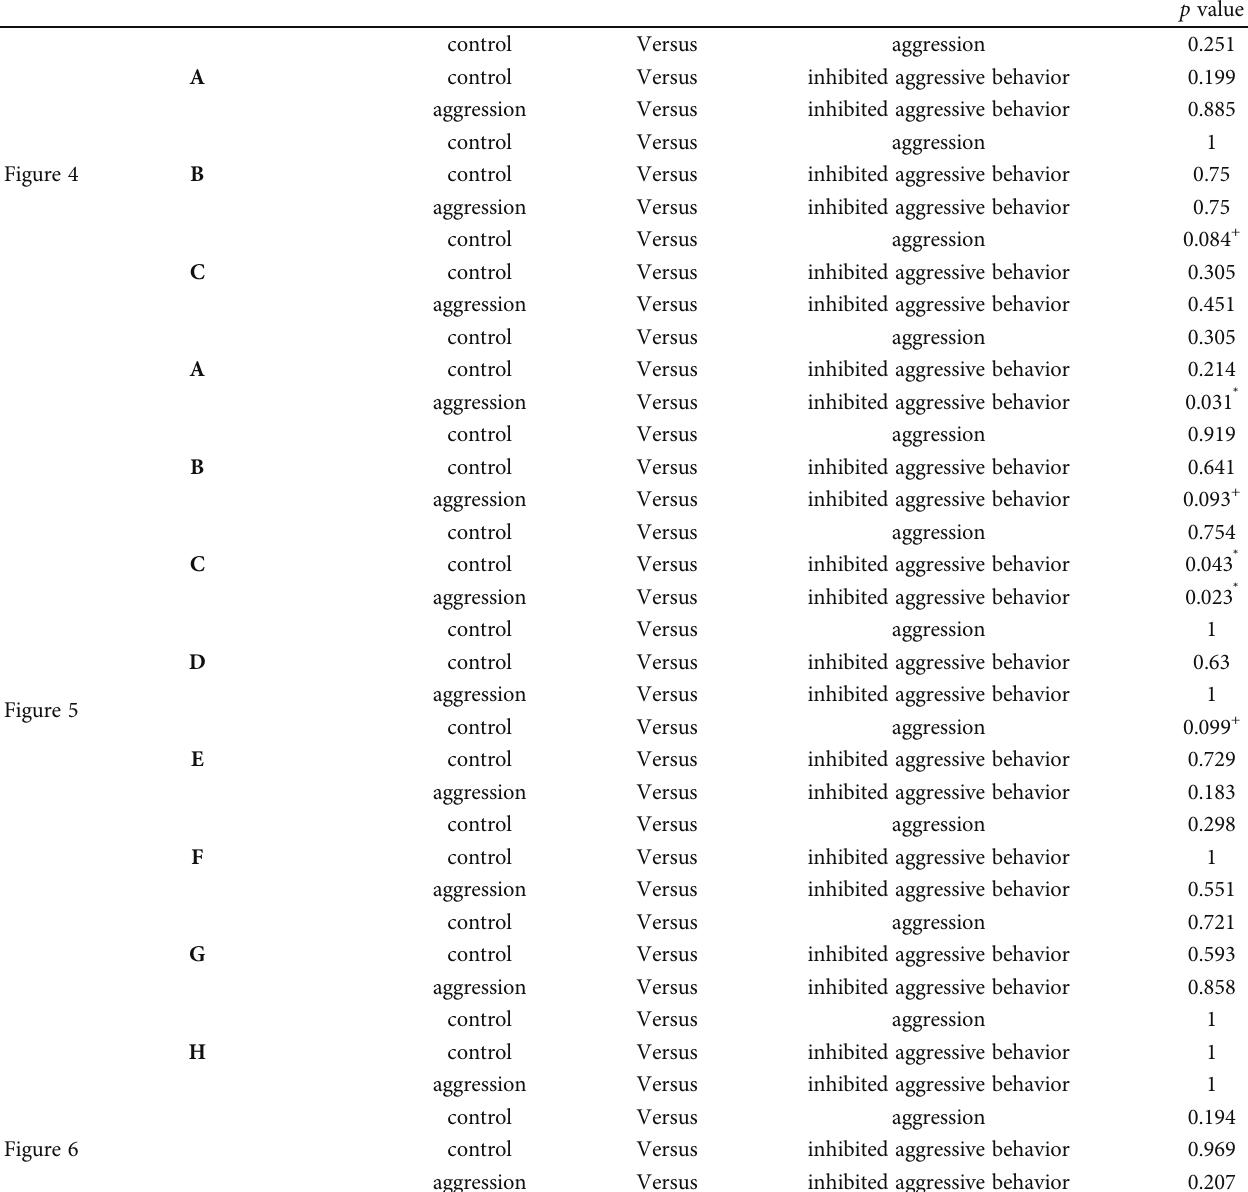
Table 2: Signi fi cance levels for the e ff ects reported in Figures 4 –